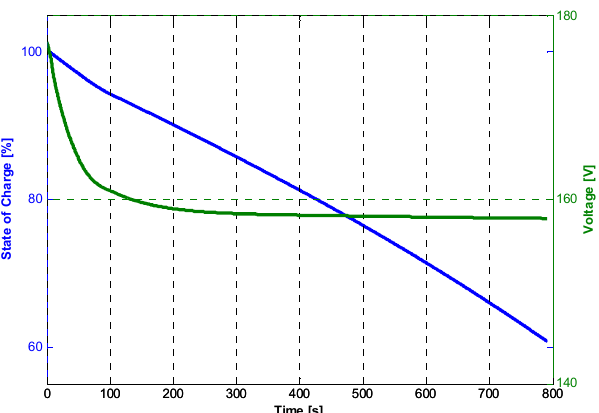
Figure 12. Real-time simulation of the case 11 Ah, n p = 21, n s = 29, 270 V on the DC-link: SoC (blue line) and output voltage (green line).